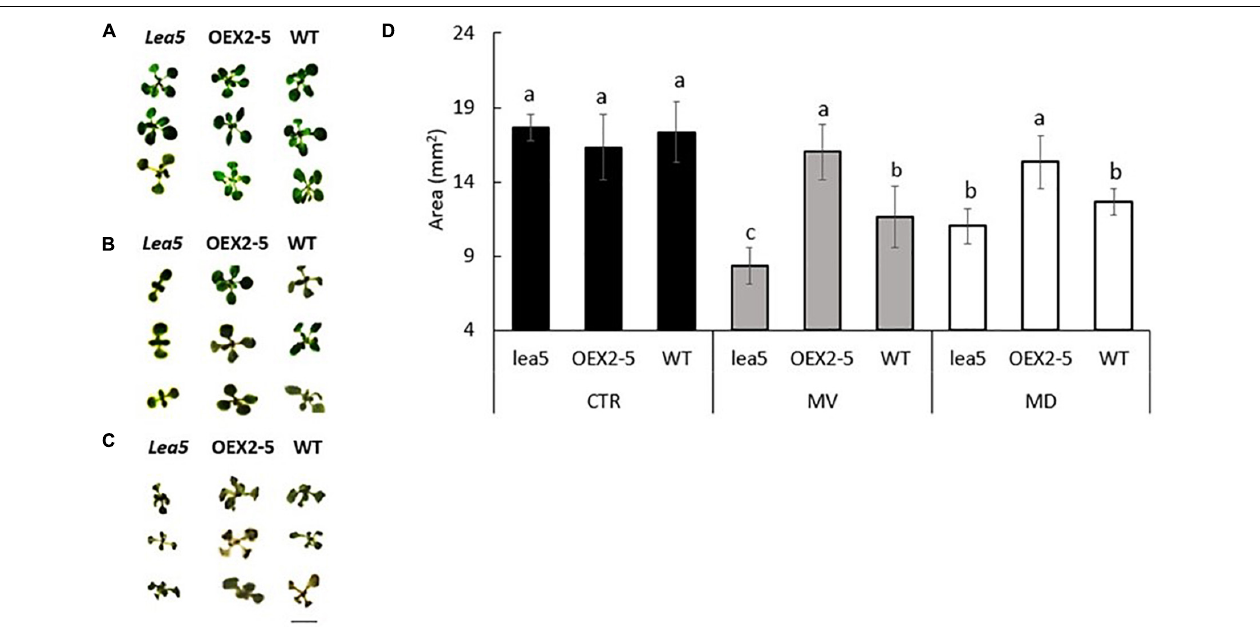
FIGURE 1 | The rosette phenotypes (A–C) and growth (determined as rosette area) of wild type Arabidopsis (WT), mutants defective in LEA 5 ( lea5 ) and a transgenic line overexpressing the LEA5 protein (OEX2-5) in the absence or presence of the prooxidants menadione and paraquat (D) . (A) Controls, (B) seedlings grown in the presence of 0.1 µ M paraquat or (C) 0.1 mM menadione. Error bars represent mean +/– standard error. Different letters indicate significance. Statistical analysis was performed using One Way ANOVA and post hoc Tukey test. Scale bar is 5